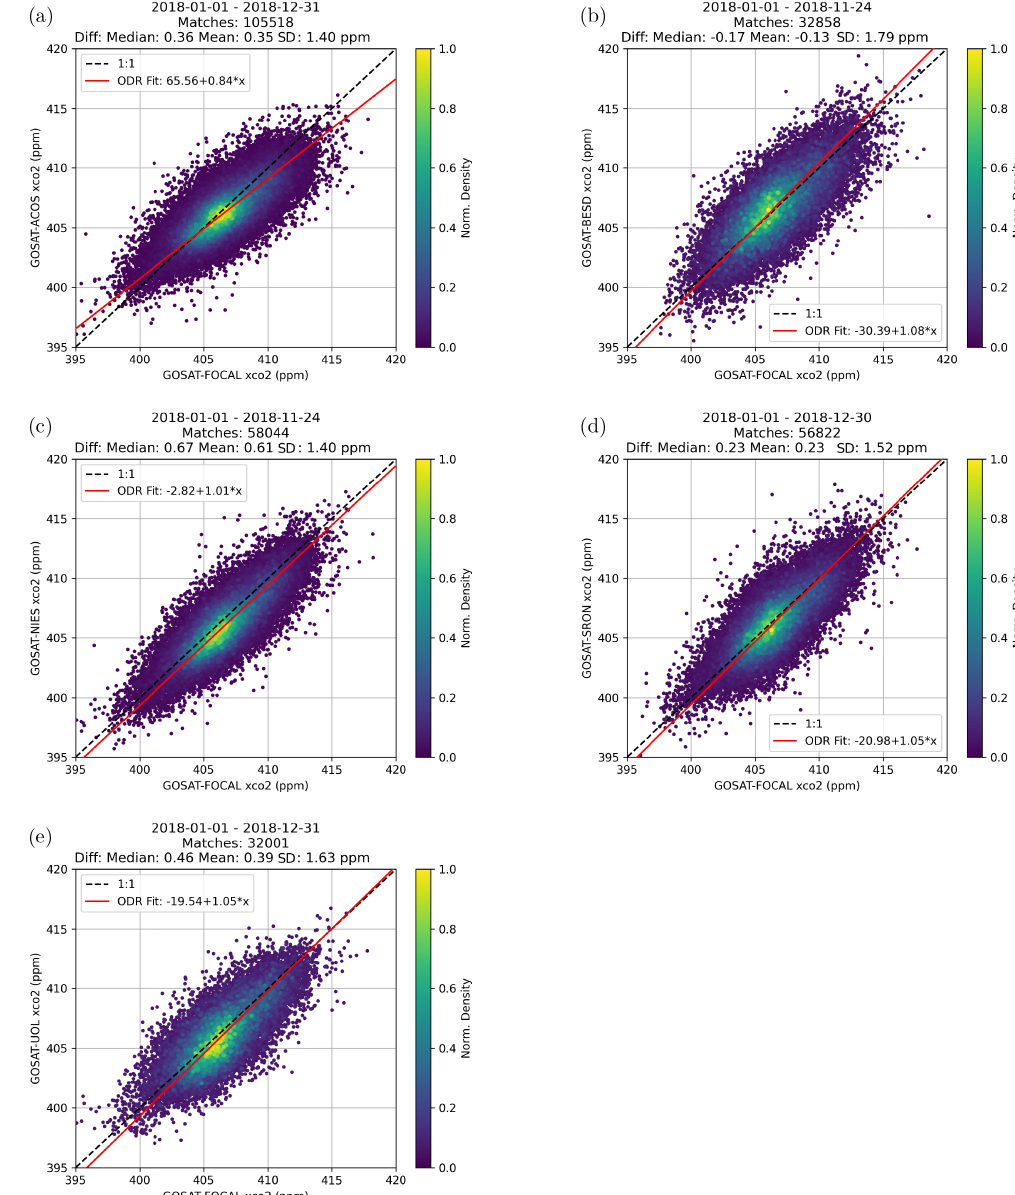
Figure 14. Comparison of GOSAT-FOCAL data ( x axis) from 2018 with other GOSAT data ( y axis). The colour of the data points corre- sponds to the density of data points at that location (normalised to a maximum value of 1). The dashed line corresponds to perfect agreement. The red line shows the result of a linear fit using the orthogonal distance regression (ODR) method. The total number of collocated data as well as the median, mean, and standard deviation of the XCO 2 differences between the two data sets are given in the title of the sub-plots. (a) FOCAL vs. ACOS. (b) FOCAL vs. BESD. (c) FOCAL vs. NIES. (d) FOCAL vs. SRON. (e) FOCAL vs.